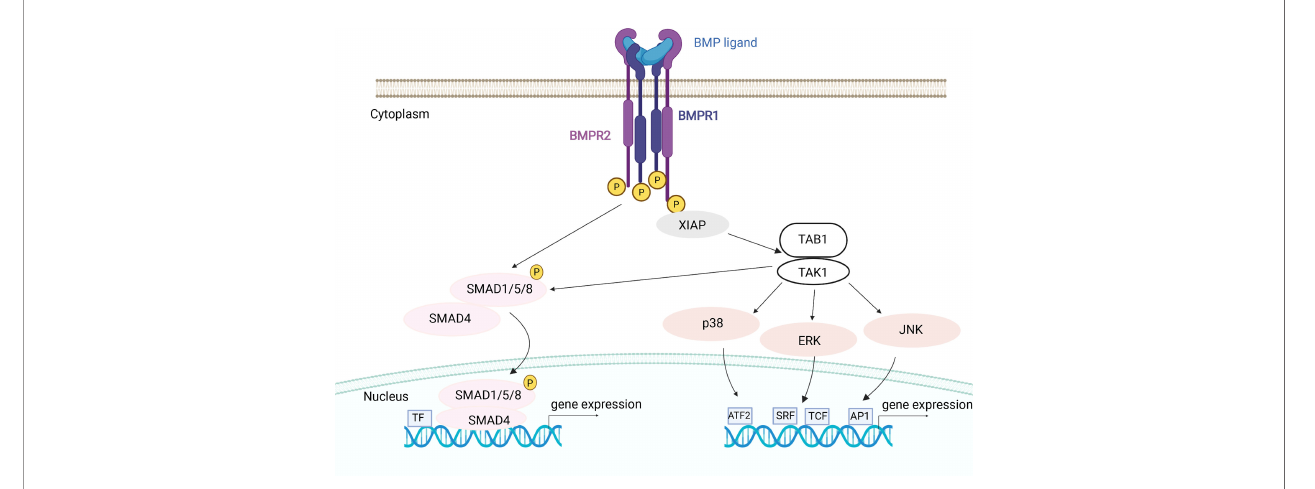
FIGURE 4 | BMP mechanisms of canonical and non-canonical signaling in osteoclasts. After BMP ligand binding type II receptors phosphorylate (P) the type I receptors. Activated type I receptors recruit and phosphorylate canonical pathway speci fi c R-SMADs (SMAD1/5/8) which, with the help of co-SMAD (SMAD4), transduce the signal into the nucleus. The non-canonical BMP signaling pathway is transduced by the recruitment of TAB1/TAK1 complex through XIAP. Activated TAK1 kinase can stimulate the downstream non-canonical MAP kinase effector proteins or canonical SMAD proteins. Activated MAPKs can translocate to the nucleus to phosphorylate a number of transcription factors (TF), thereby changing target gene transcription. BMPR1 and BMPR2, BMP receptor 1 and 2; XIAP, X-linked inhibitor of apoptosis protein; TAK1, TGF b Activated Kinase 1; TAB1, TGF b Activated Kinase 1 binding protein; p38, mitogen-activated protein kinase 38; JNK, c-Jun N-terminal kinase; ERK, extracellular regulated kinases; SRF, serum response factor; TCF, ternary complex factor family member; AP1, activator protein 1 complexes; ATF2, activating transcription factor 2. Image created by